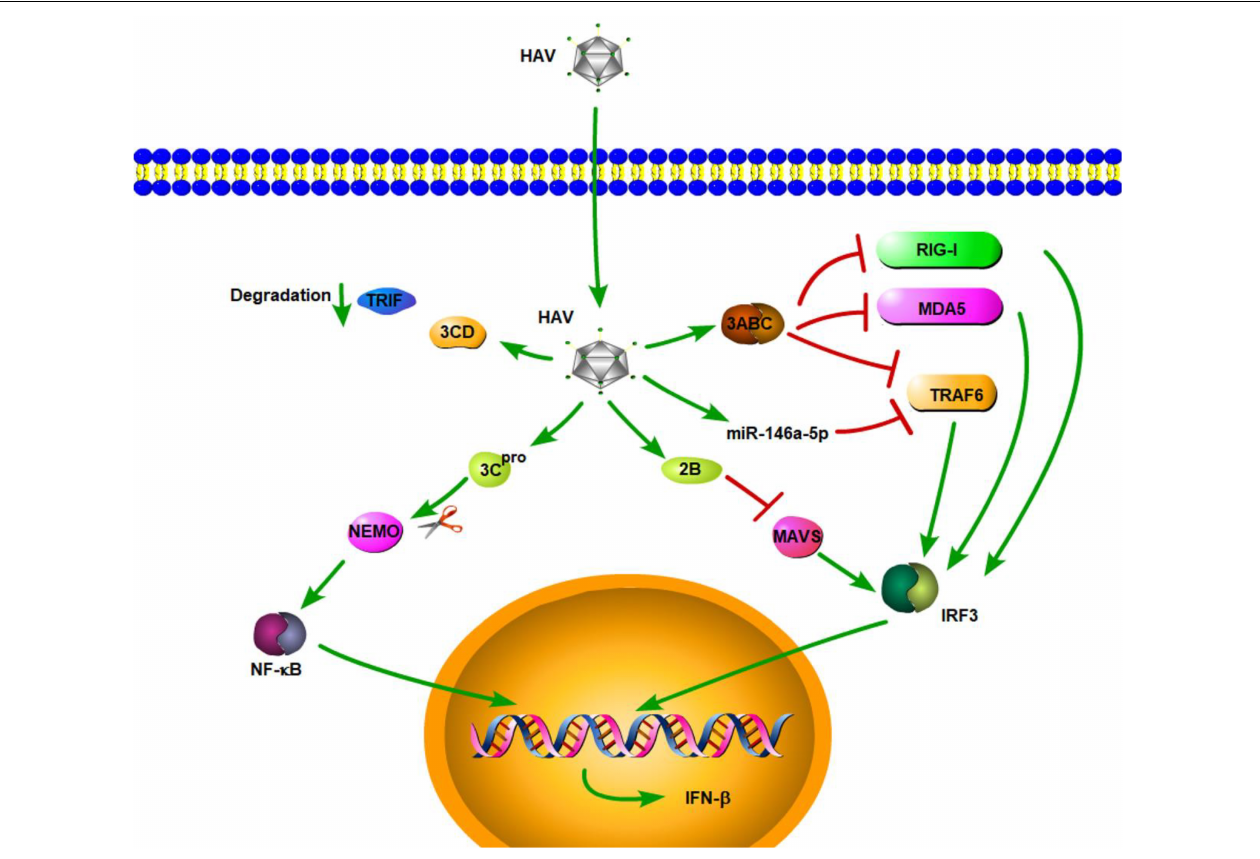
FIGURE 1 | Hepatitis A virus suppression of type I interferon (IFN) response (green arrows indicate the related signaling pathways and T-arrows in red indicate blocking the targets). HAV 3ABC downregulates MAVS to disrupt the RIG-I and MDA5 pathways, thereby inhibiting the type I IFN response. HAV increased the expression of hsa-miR-146a-5p, thus leading to the cleavage of TRAF6.HAV 3CD can induce TRIF degradation. HAV 3C pro cleaves nuclear factor- κ B essential modulator (NEMO), the regulatory subunit for I κ B kinase (IKK) that controls the NF- κ B signaling pathway. HAV 2B interferes with the activity of MAVS and affects the function of IRF3